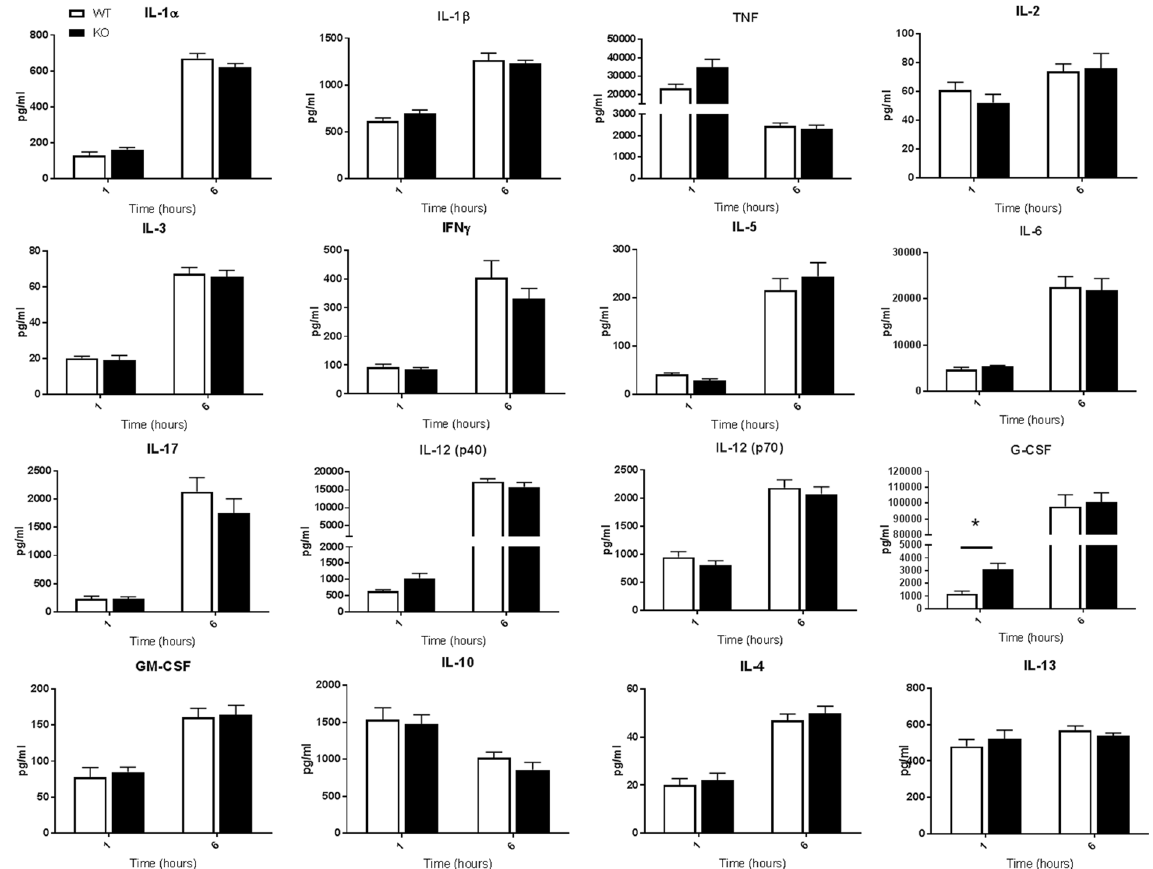
Figure 7. Serum cytokine levels in WT and ficolin KO mice after LPS challenge with a lethal dose. Groups of WT and ficolin KO mice were intraperitoneally injected with LPS of a lethal dose (10 mg/kg). At 1 h or 6 h after challenge, blood was collected before the mouse was sacrificed. The serum concentration of inflammatory cytokines was measured by a multiplex Luminex assay; the data was obtained from two independent experiments per time point and represent mean ± SEM (n = 11 mice per group per time point). * p < 0.05 for WT to ficolin KO comparisons (unpaired two-tailed Student’s t